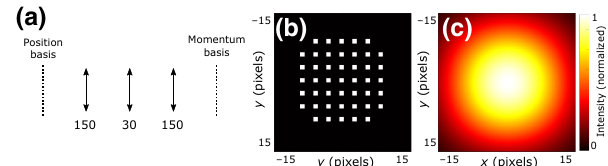
FIG. 8. The measurement of unbiasedness. (a) An experimen- tal configuration representing the optical transformation that links the position and momentum bases in our experiment. (b) The spatial arrangement of the 45 selected pixels in the